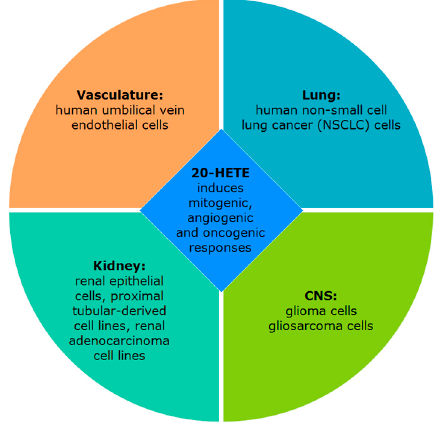
Figure 6. 20-HETE role in carcinogenicity. 520